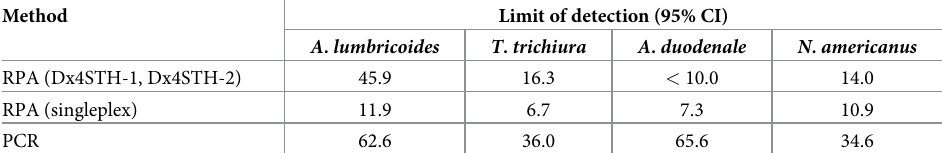
Table 2. Limit of detection of each RPA assay as determined by probit analysis using 10 to 20 replicates per con- centration tested. Method